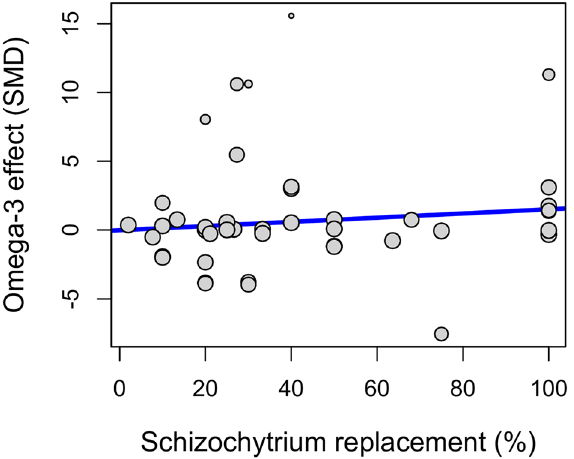
Figure 7. Bubble plot showing the estimated regression slope of the meta-regression on the effect of Schizochytrium replacement (%) on the Standardized Mean Difference in the omega-3 fillet content. The size of the points is proportional to the weight of each study.